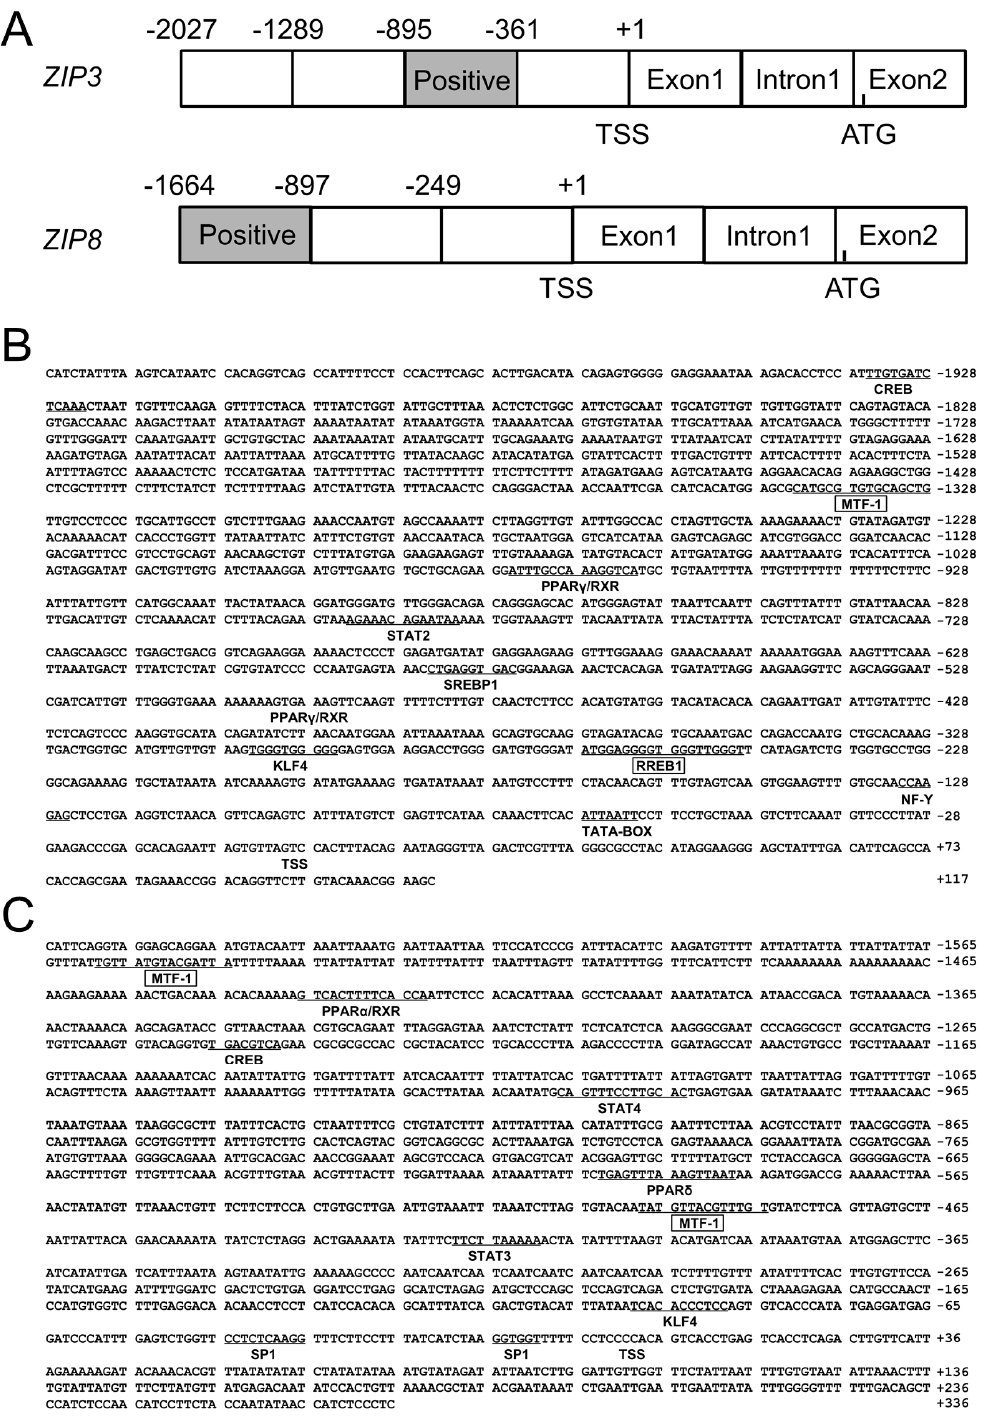
Figure 1. ( A ) The schematic diagram of ZIP3 and ZIP8 gene structures. Positive: the region that positively regulated the promoter activity. TSS: transcription start site. ATG: translation initiation site; ( B ) Nucleotide sequence of yellow catfish ZIP3 promoter. Numbers are relative to the transcription start site ( + 1). The putative transcription factor binding sites are underlined. The highlighted sequences show putative transcription factor binding sites of MTF-1 and RREB1 ; ( C ) Nucleotide sequence of yellow catfish ZIP8 promoter. Numbers are relative to the transcription start site ( + 1). The putative transcription factor binding sites are underlined. The highlighted sequences show putative transcription factor binding sites of MTF-1